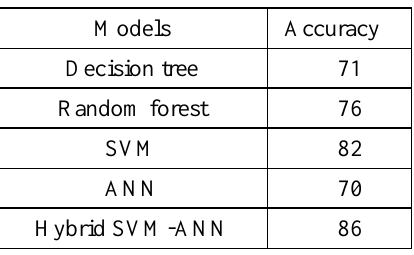
Table 2. Comparative performance metrics for various machine learning algorithms